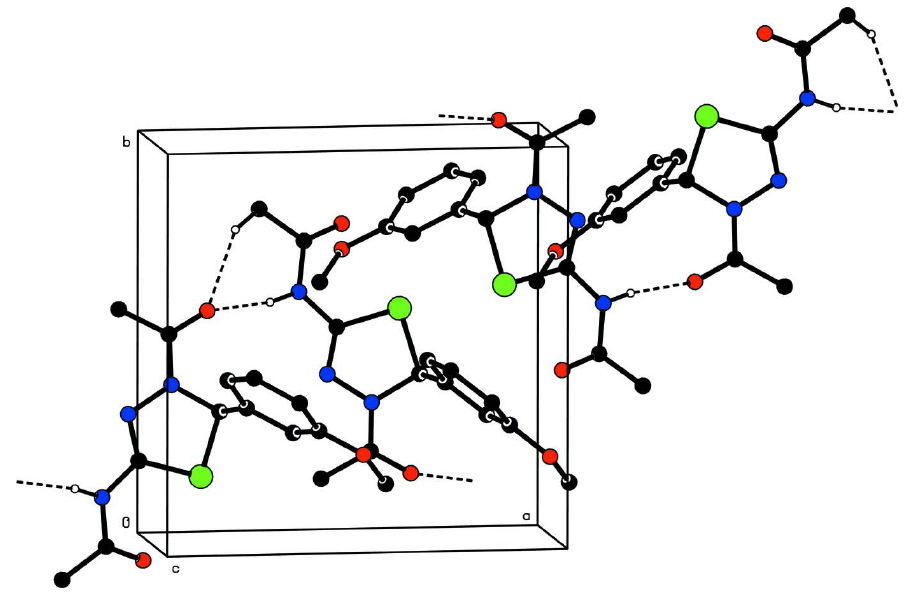
Figure 1 The molecular structure of the title compound, showing 30% probability displacement ellipsoids.